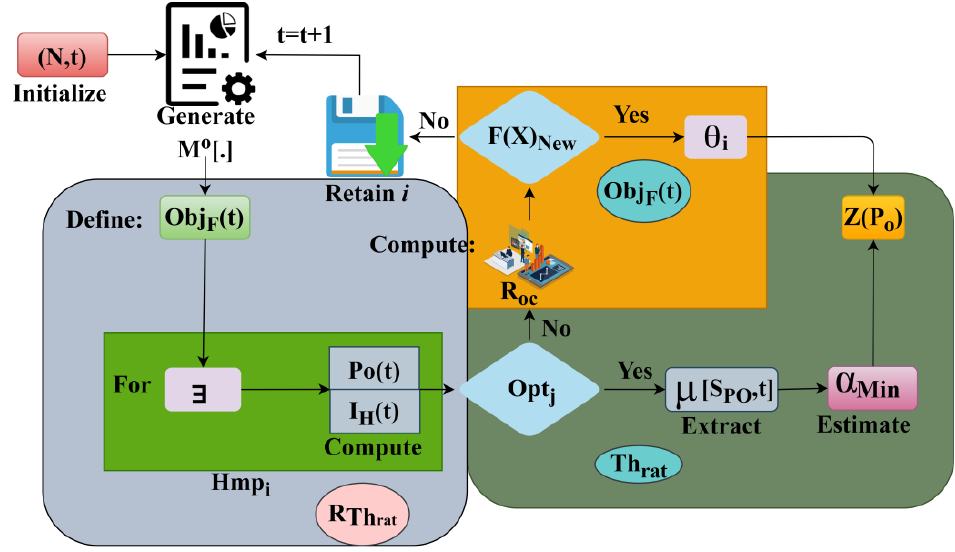
Figure 4. Harmony Search Process.